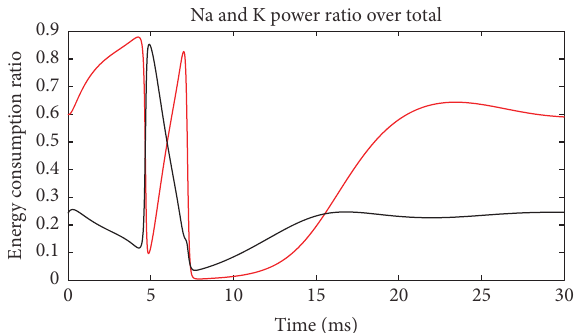
Figure 5: Energy consumption of each ion channel (suprathresh- old).